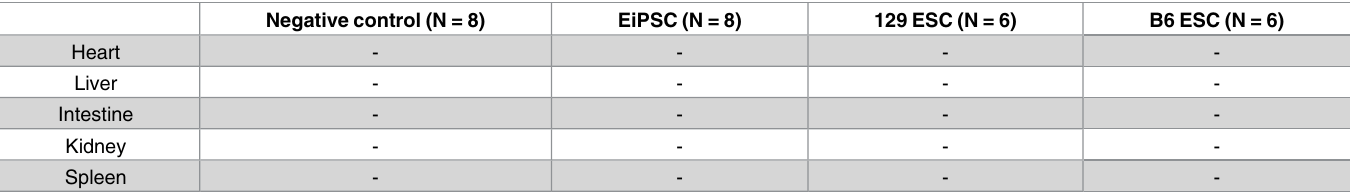
Table 1. One year H&E pathological evaluation in organs of mice from the sciatic nerve model with various types of pluripotent stem